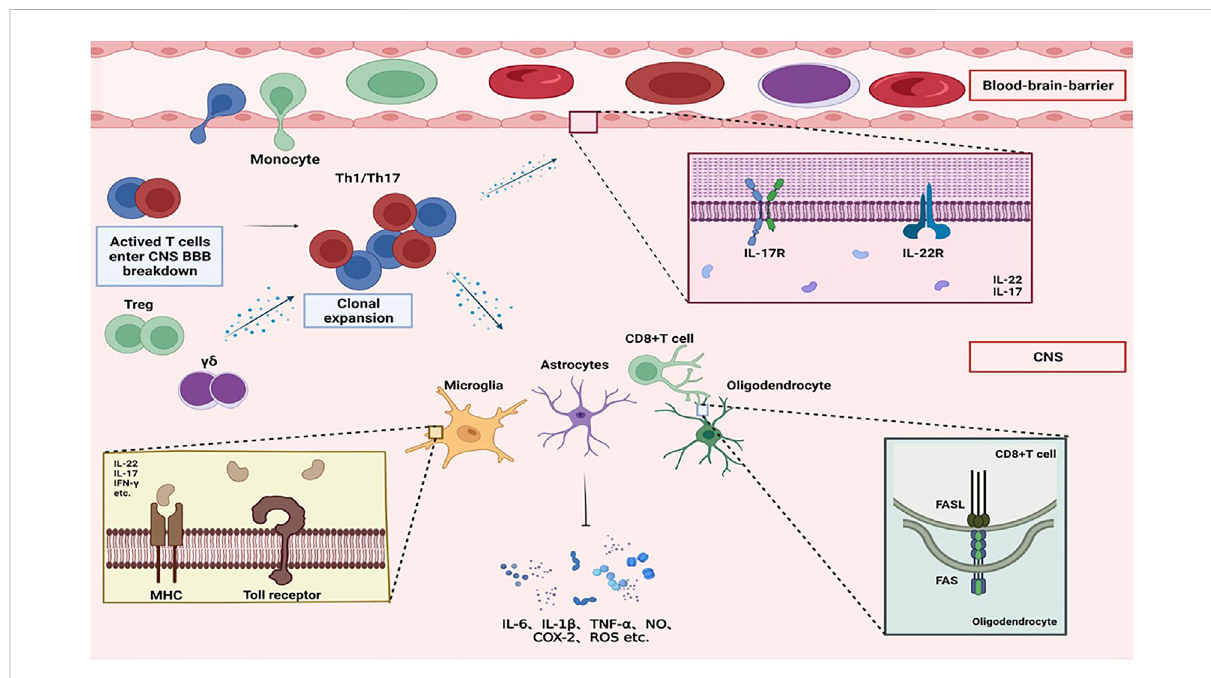
FIGURE 1 Overview of molecular mimicry. Mononuclear macrophages in the body phagocytose and digest antigenic substances (such as erroneous protein deposits in neurodegenerative diseases) and transmit antigenic signals that have common antigenicity with myelin basic protein to helper T cells. After activation, it enters the CNS, activates effector T cells, releases a large number of cytokines, and activates complement and B cells, resulting in the activation of microglia and astrocytes and the release of neurotoxic substances, oligodendrocyte apoptosis, and myeloid cells. The sheath is damaged, eventually leading to the onset of neurodegenerative